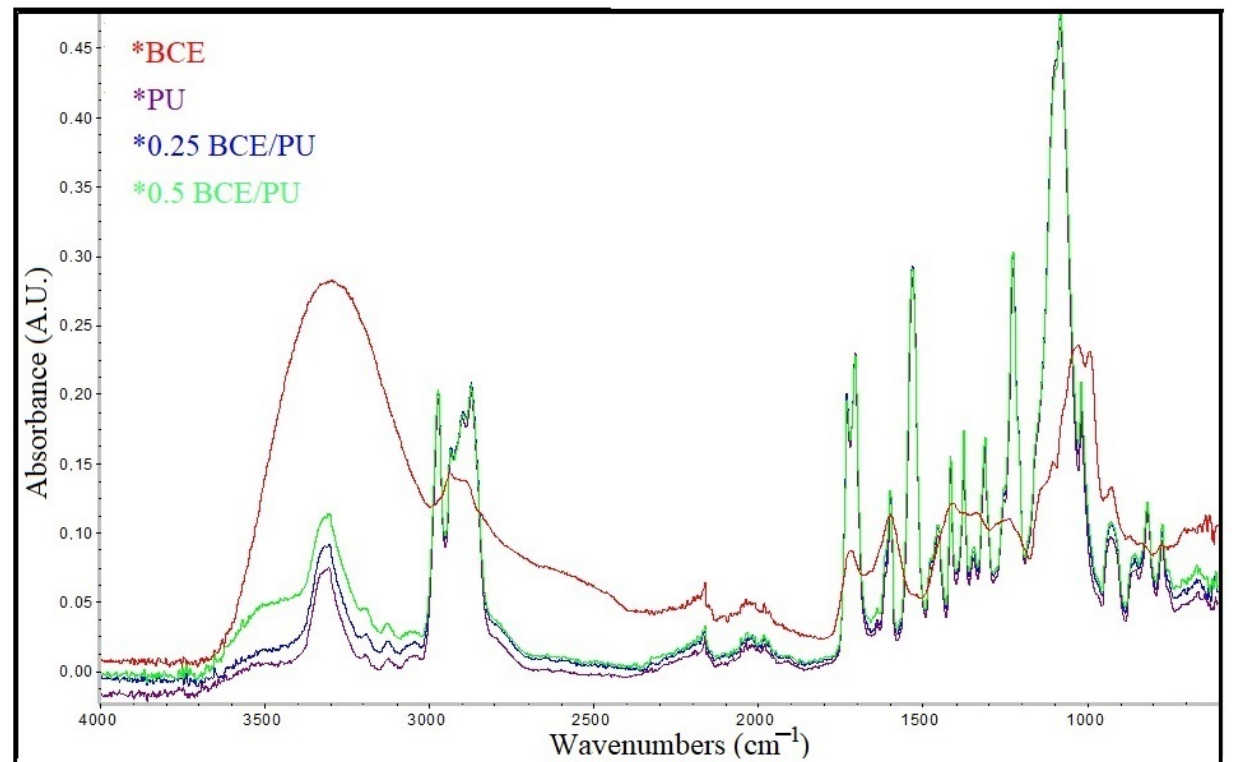
Figure 3. ATR-FTIR spectra of BCE, the electrospun PU, and BCE/PU nanofibrous.